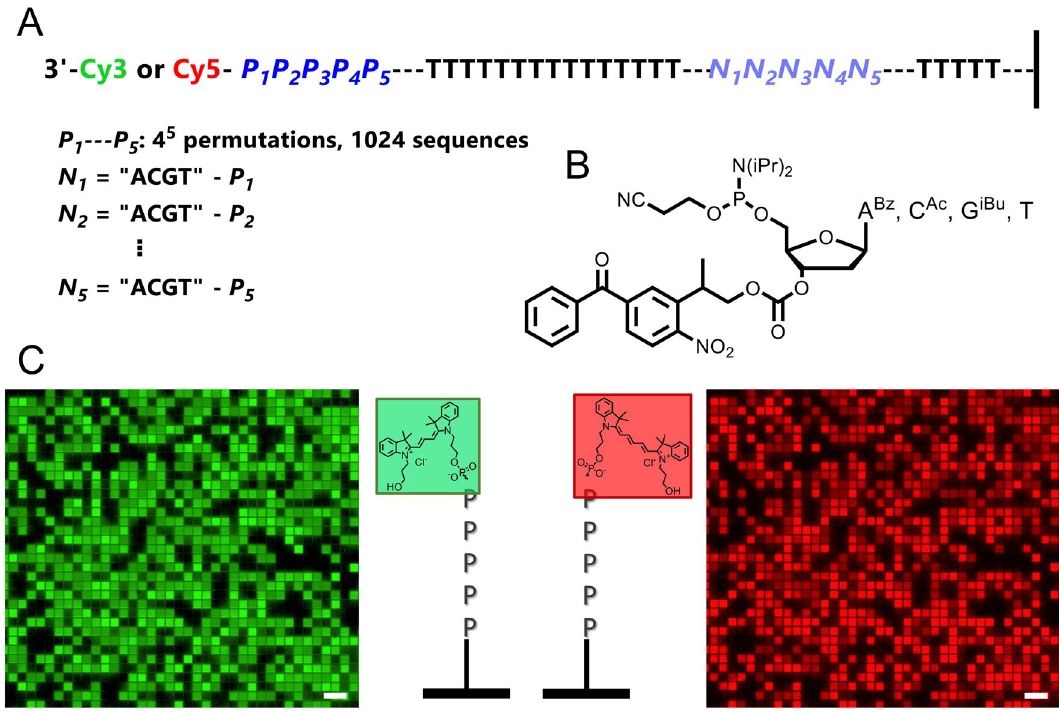
Figure 1. ( A ) Oligonucleotide sequence design for 3 ′ -Cy3 and Cy5 labeled single-stranded DNA. The oligonucleotides consist of a 3 ′ terminal dye followed by the permutation library (P 1 –P 5 , 1024 combinations) and a T 15 region. The T 15 acts as a spacer between the P permutation section and an “adjustment” section composed of 5 trinucleotides N x which are each in the form of 3 ′ -ACGT minus the nucleotide P x . A T 5 linker connects the sequence to the surface of the glass slide. ( B ) Chemical structure of the 3 ′ -BzNPPOC 5 ′ DNA phosphoramidites used to perform 5 ′ → 3 ′ reverse microarray synthesis. ( C ) Excerpts of Cy3 and Cy5 microarray scans (~ 5% of total synthesis area) at 532 and 635 nm, respectively. Single-stranded oligonucleotides are randomly distributed across the surface of the array, separated by non-synthesized space serving as background reference. Scale bar is ~ 200